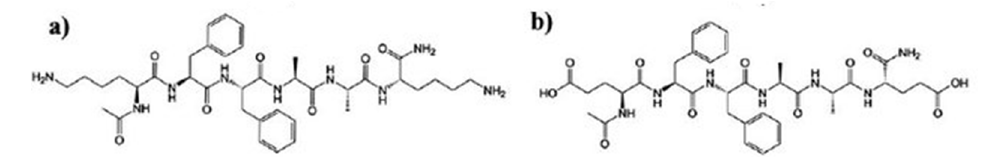
Figure 6. Molecular structure of P1 ( a ) and P2 ( b ) peptides reported in [95], with permission from the Royal Society of Chemistry.